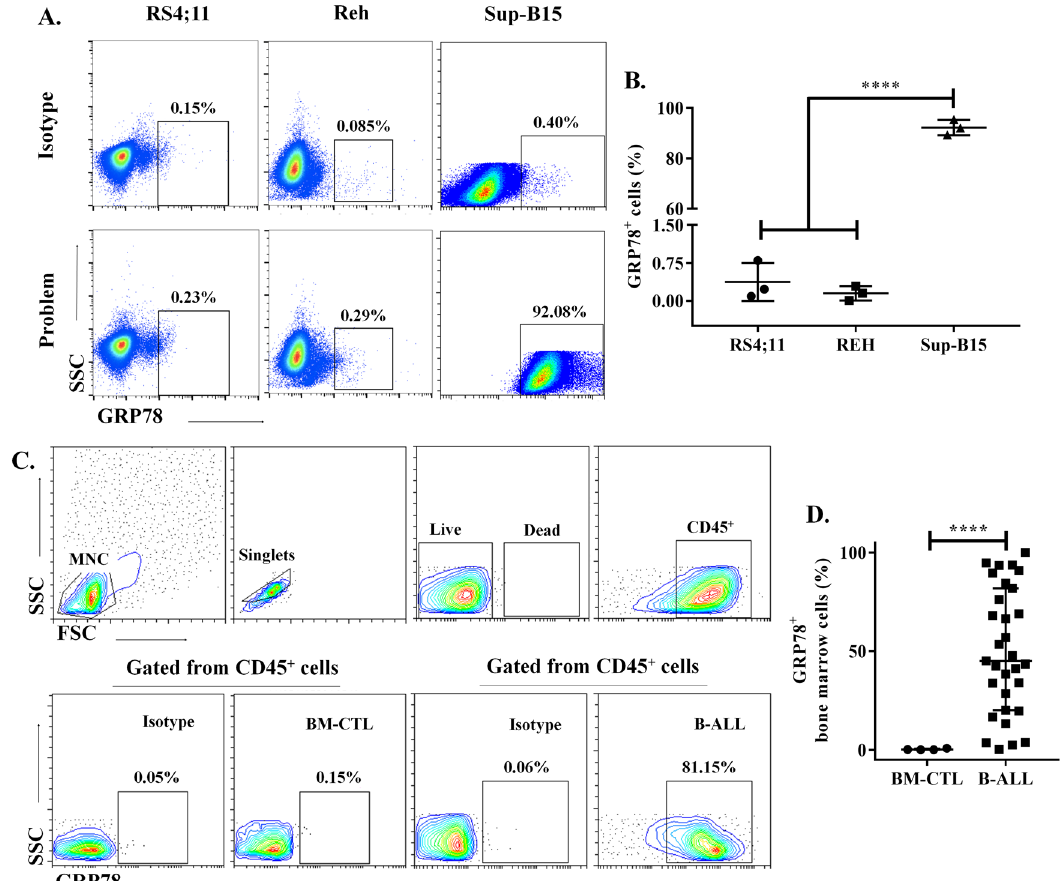
Figure 1. sGRP78 expression on bone marrow cells of pediatric individuals with newly diagnosed B-ALL. ( A ) Acute lymphocytic leukemia cell lines were stained with anti-GRP78 antibody and representative experiments of each cell line are depicted. ( B ) Statistical representation of cell surface GRP78 + cells in leukemic cells lines is shown. Data are the mean plus SEM of n = 3. Statistical analysis was performed by One-way ANOVA, p < 0.0001. ( C ) Gating strategy for sGRP78 + cells analysis from bone marrow derived cells of pediatric individuals with B-ALL and controls (BM-CTL). ( D ) Statistical representation of cell surface GRP78 + cells in BM-CTL (n =